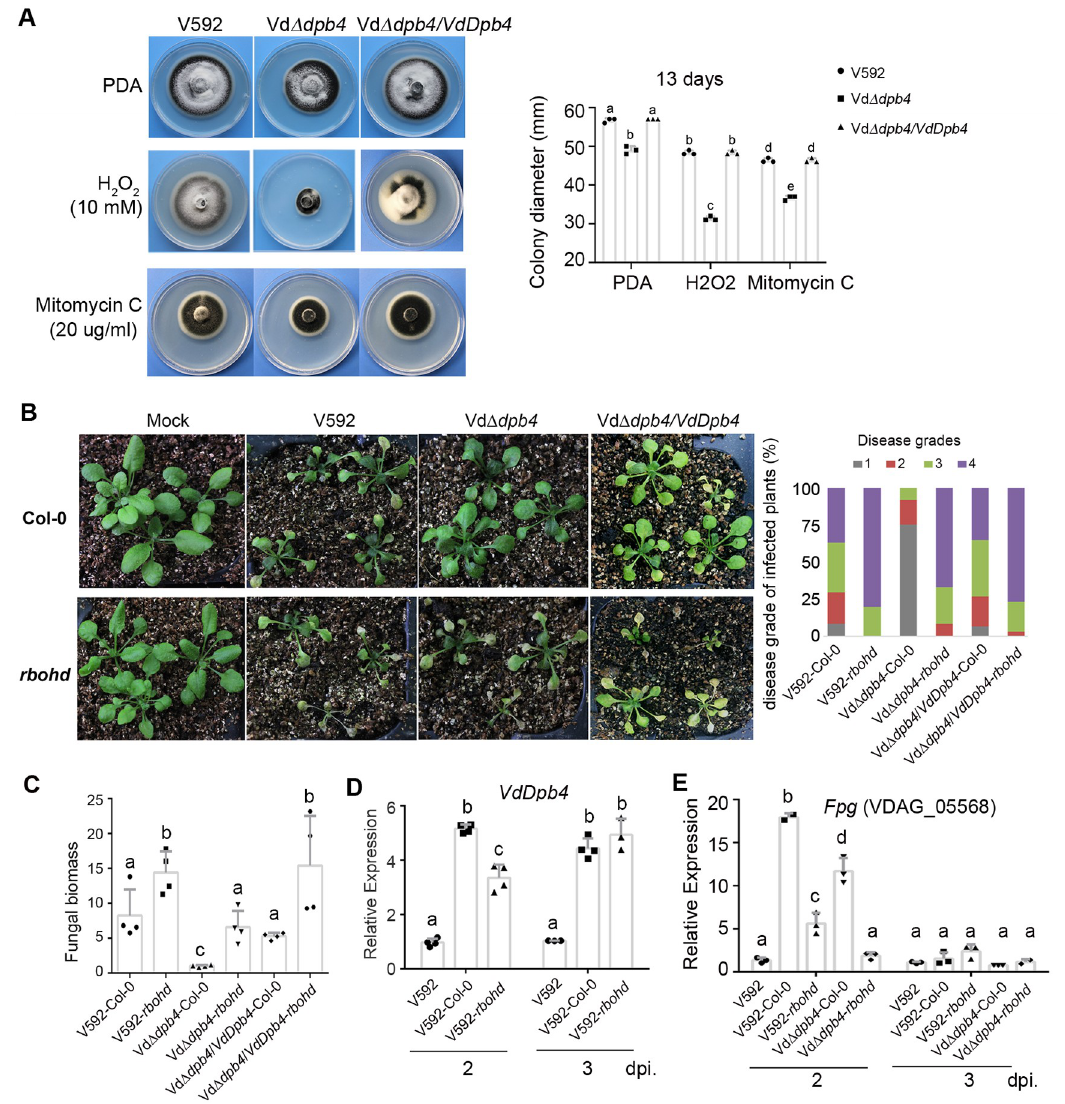
Fig 2. VdDpb4 is essential for resistance to reactive oxygen species. A. Mycelial growth on PDA agar medium in the presence of different DNA-damaging agents and quantification of colony diameter. Different letters indicate significant differences ( P < 0.05, mean ± SD, one-way analysis of variance (ANOVA) followed by Tukey’s multiple comparisons test). B. VdDpb4 is essential for resistance to RBOHD-mediated defense. Disease symptoms of wild-type (Col-0) and rbohd mutant Arabidopsis plants infected with V592, mutant or complementation strains at 20 dpi. The disease grades were evaluated with three replicates of 48 plants for each inoculum. C. Reduced fungal biomass in Vd Δ dpb4 -infected Arabidopsis plants compared with V592-infected ones at 2-week postinoculation. The values were quantitative real time (qPCR) of fungal tubulin DNA relative to Arabidopsis At4g33380 DNA. Statistical analysis as described in A. D. Expression of VdDpb4 was rapidly induced at 2- and 3-dpi during Arabidopsis plant infection as detected by reverse transcription qPCR (RT-qPCR). The value of VdDpb4 mRNA relative to elf1- α at 2-dpi was arbitrarity designated as 1. Statistical analysis as described in A. E. Expression of Fpg was rapidly induced at 2-dpi during wild type Arabidopsis plant infection as detected by reverse transcription qPCR (RT-qPCR). Statistical analysis as described in A. osmotic pressure. As shown in Fig 2A, Vd Δ dpb4 had a reduced growth rate in the medium containing 10 mM H O to approximately 50% compared to the WT and complementation 2 2 strains, whereas, retaining the intense melanized microsclerotial formation, Vd Δ dpb4 showed no significant differences in growth rate (colony diameter) compared to the WT on the media